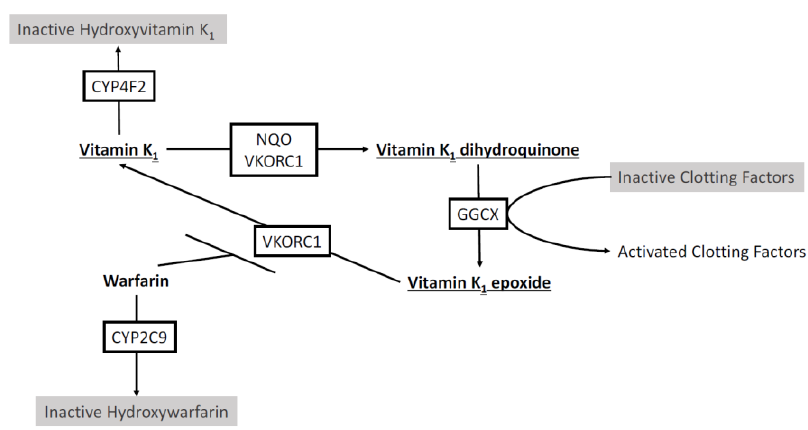
Figure 1. Schematic of the effect of warfarin and involvement of CYP2C9, CYP4F2, and vitamin K epoxide reductase complex subunit 1 (VKORC1) on the vitamin K cycle. VKORC1 and